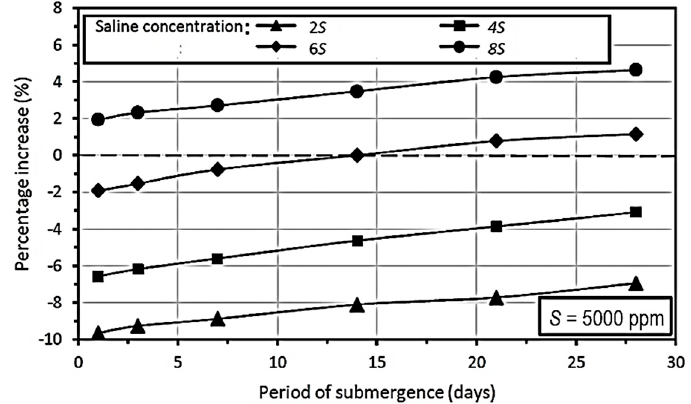
Figure 4. Variation in the percentage increase of G with period of submergence.